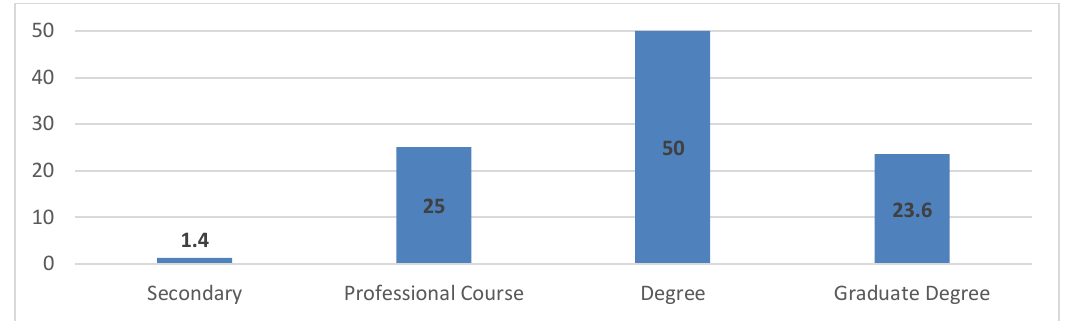
Figure 5: Respondent’s Highest Level of Education; Source: Survey Data